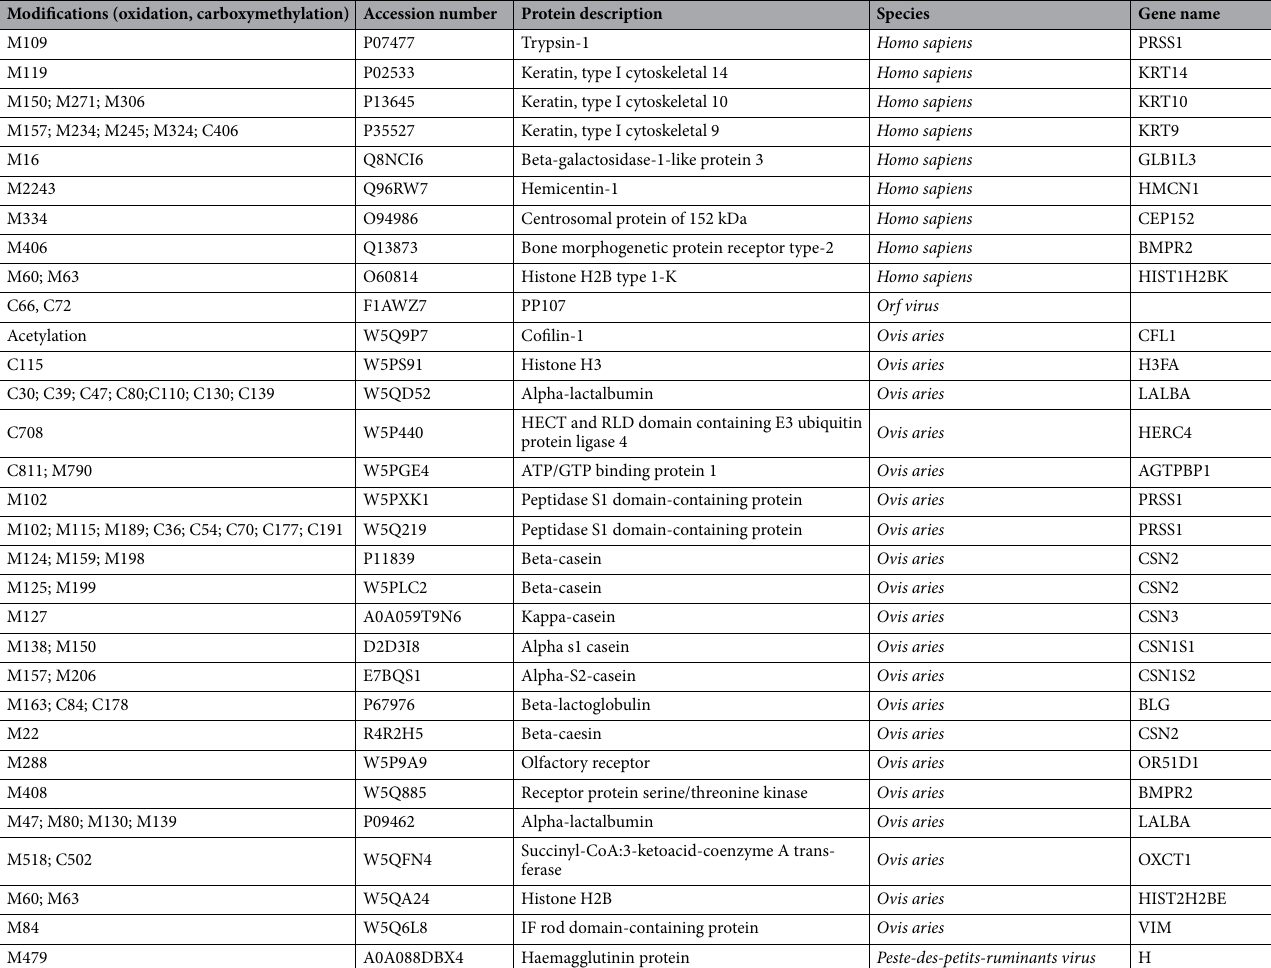
Table 4. Oxidation and carboxymethylation sites as observed in high and low abundance goat milk